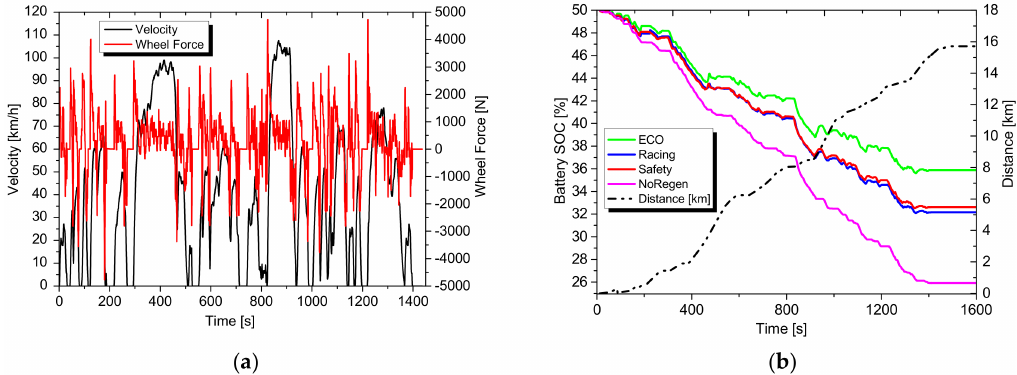
Figure 21. ( a ) Wheel horizontal braking force in LA92; ( b ) economy simulation results for each strategy.